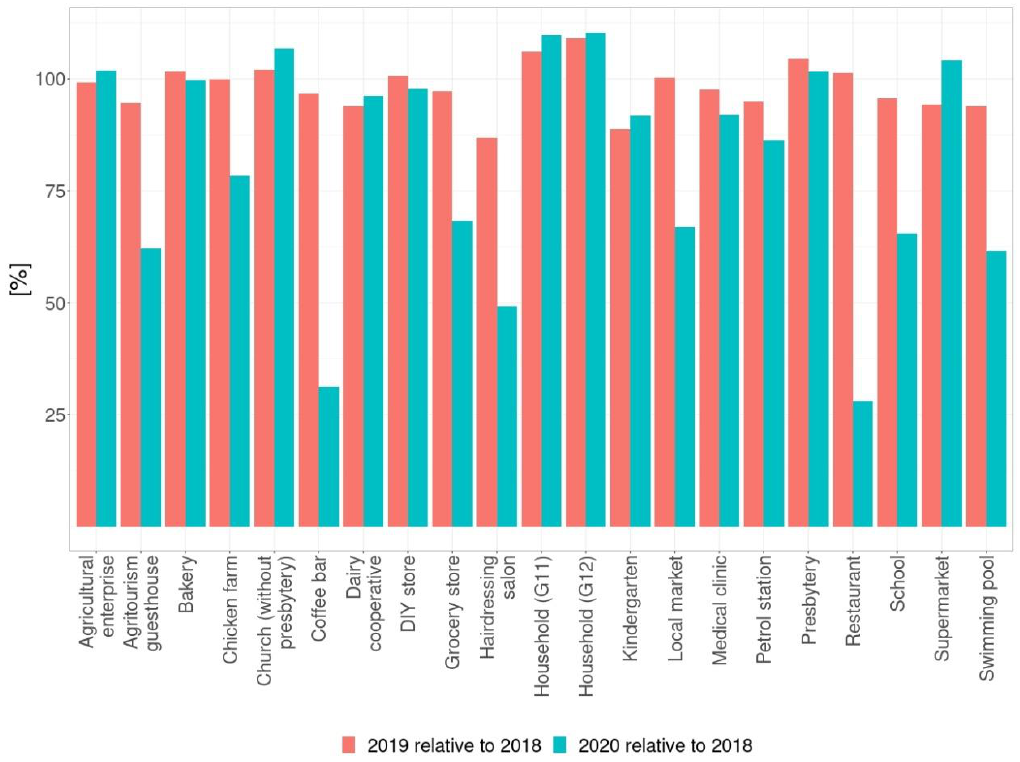
Figure 7. Change in electricity consumption from the network